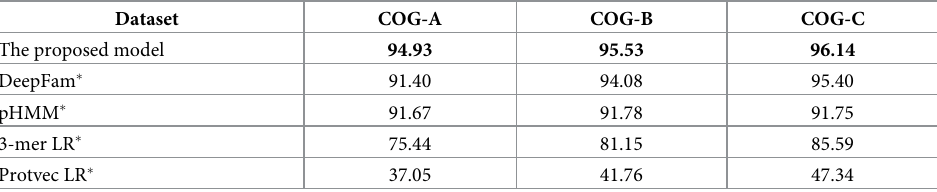
Table 4. The prediction accuracy (%) comparison of COG A, B and C datasets.